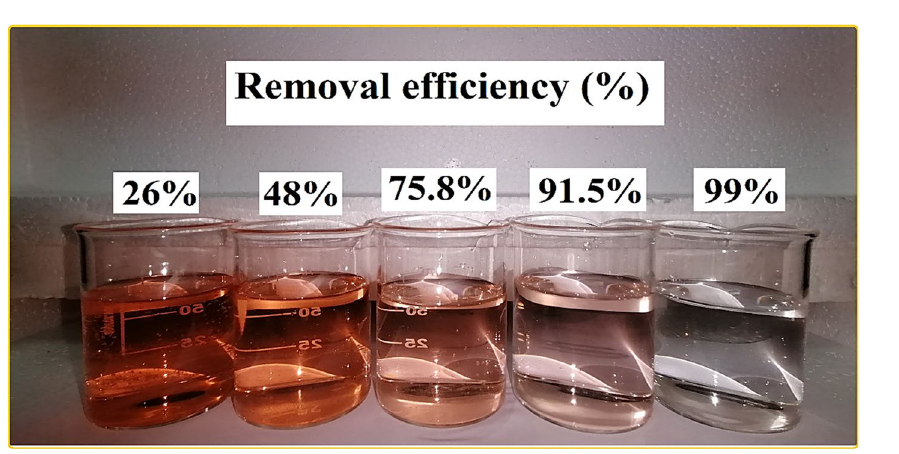
Figure 11. The color change of RO16 solution during purification by lignocellulosic sawdust-Fe/Zn bio-